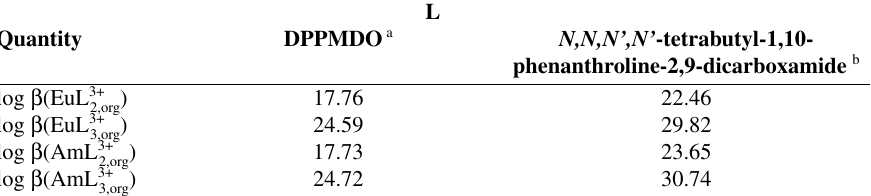
and ML 3+ (M 3+ = Eu 3+ , Am 3+ ; L = N,N,N’,N’ -tetra- 2 3